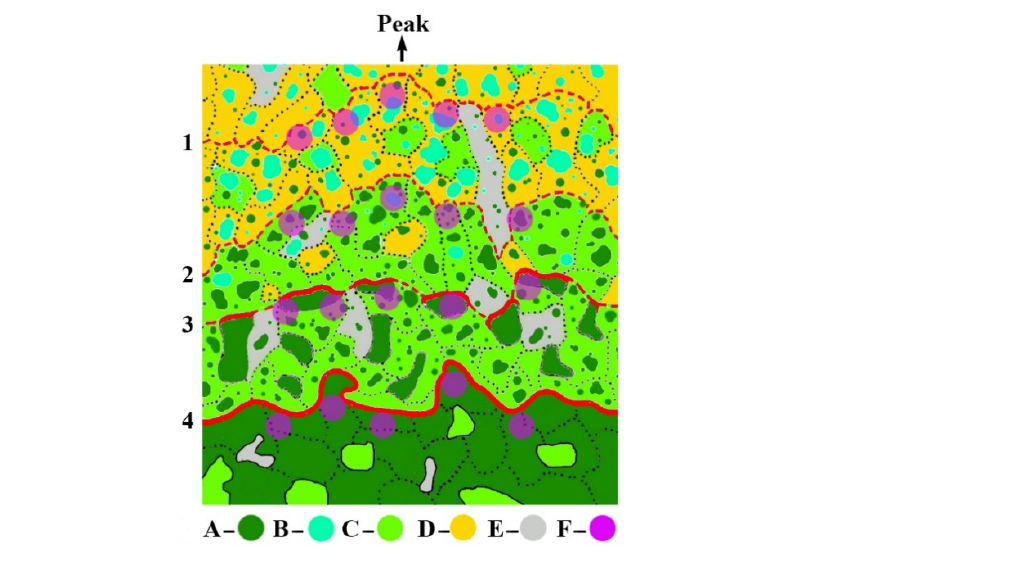
Figure 3. General scheme of the forest–tundra transition with locations of study plots (F); 1—sparse tree stands line; 2—open forests line; 3—contemporary closed forests line; 4—the closed forests line in the 1950s–1960s. Areas with prevailing covers of: (A)—trees; (B)—shrubs; (C)—meadow species; (D)—tundra species; (E)—stony fields.